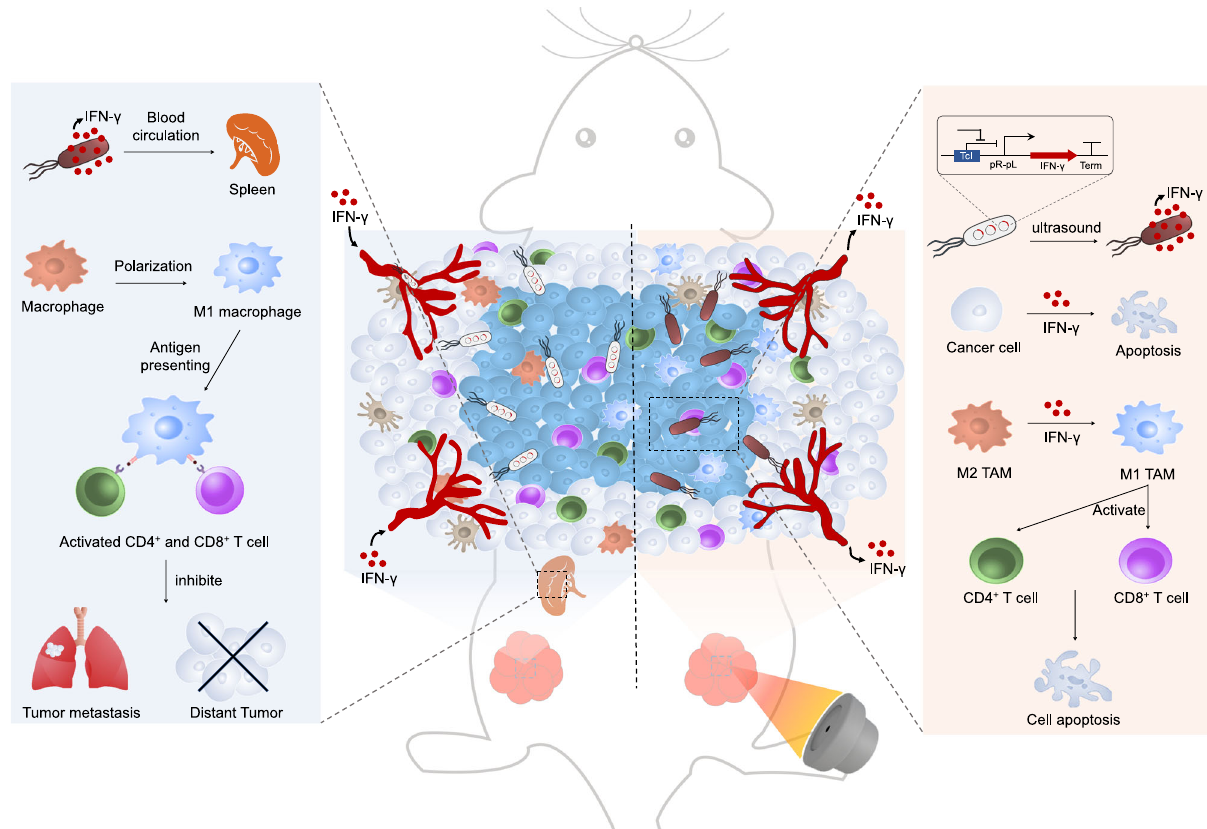
Fig. 1 Schematic diagram of URB in controlling IFN- γ expression by focused ultrasound and their mechanisms for cancer immunotherapy. Upon systemic administration of URB that contains IFN- γ gene inserted in the temperature-sensitive genetic circuit, these genetically engineered bacteria would deliver into the tumors due to their tumor-targeting capability. Then, the tumor was irradiated by focused ultrasound to heat these intratumoral bacteria to 42 – 45°C for inducing the expression of IFN- γ gene. The production and secretion of IFN- γ not only can promote the apoptosis of cancer cells, but also induce the macrophage polarization from M2 to M1 phenotype and the activation of CD4 + and CD8 + T cells (Right panel).In addition, high levels of IFN- γ can also activate macrophages and T cells in the spleen to inhibit lung metastasis and distant tumor growth through immune memory responses (Left